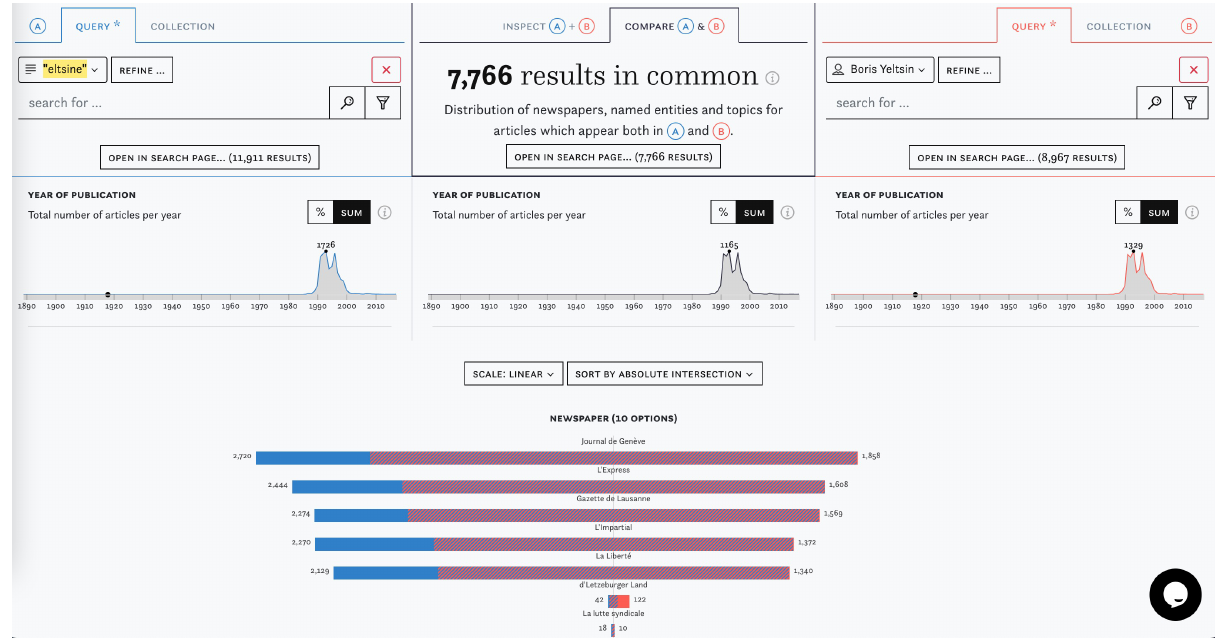
Figure 7. Screenshot from “Compare” which contrasts the string “eltsine” and the linked entity “Boris Yeltsin”.